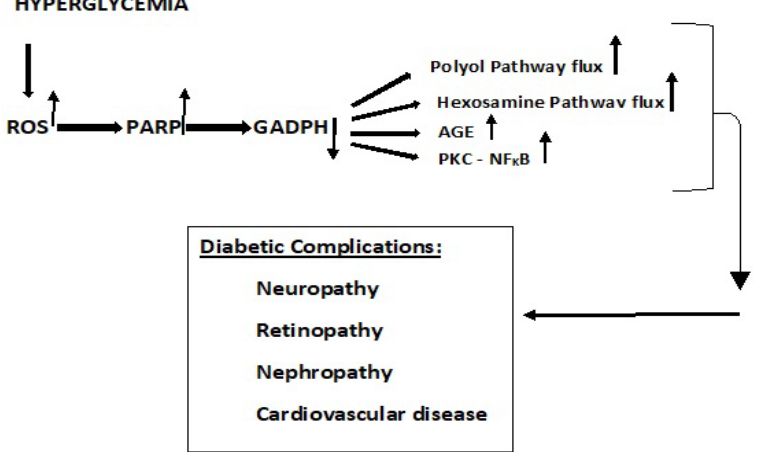
Figure 7. The influence of hyperglycemia on ROS level and activation of polyol pathway, hexosamine pathway, advanced glycation end products, and the PKC pathway, leading to tissue damage and diabetic complications [30]. Acute or chronic hyperglycemia upregulation of ROS production elevates PARP levels and downregulates GADPH levels. The latter activates and upregulates polyol and hexosamine pathways, accelerates the formation of AGE and activate PKC. These actions increase oxidative stress and ultimately impact the diabetic complications depicted. Dyslipidemia is a hallmark of DM and a major risk factor for CVD [9,30,48]. The clin- ical manifestations of dyslipidemia include high plasma triglyceride levels, low HDL cho- lesterol, and increased plasma VLDL. The lipid changes associated with T2DM are thought to be a consequence of systemic free fatty acid (FFA) flux secondary to insulin resistance [48,49]. The relationship between FFA regulation and gluconeogenesis in dia- betes has been elusive. It has been shown that at least 35% of gluconeogenesis in T2DM patients is FFA dependent [50]. An early effort to explain the competitive oxidation be- tween glucose and fatty acids resulted in what became known as the glucose–fatty acid cycle, or Randle cycle [51]. This cycle was based on two lines of evidence. First, there is evidence for changes in the rate of release of FA under different experimental conditions, and second, there is evidence that FA induces changes in carbohydrate metabolism in normal animals similar to those seen in muscle tissue in DM. A schematic of the cycle is shown in Figure 8 [52]. FFA are transported across the cell membrane by fatty acid transport protein 1 ( FATP1 ); a fatty acid acyl-CoA synthase ( FACS) yields Acyl-CoA. These reactions occur in the cytosol of the cell. Acyl-CoA is transported across the mito- chondrial membrane by carnitine palmitoyl transferase 1 ( CPT1 ).